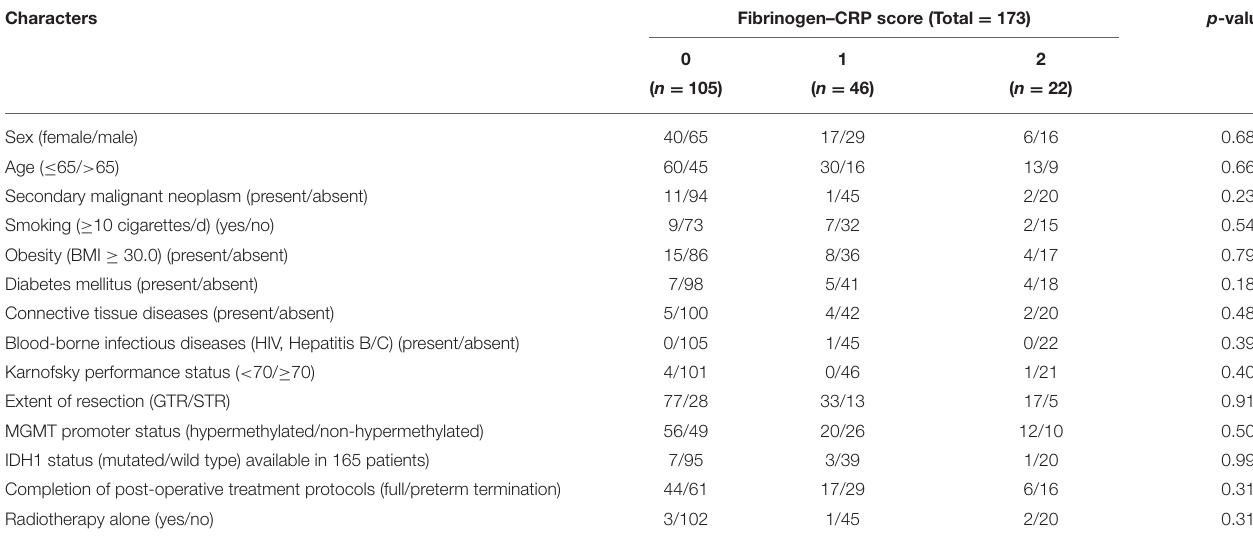
TABLE 1 | Clinicopathologic characters and fibrinogen–CRP score (Fisher’s exact test).